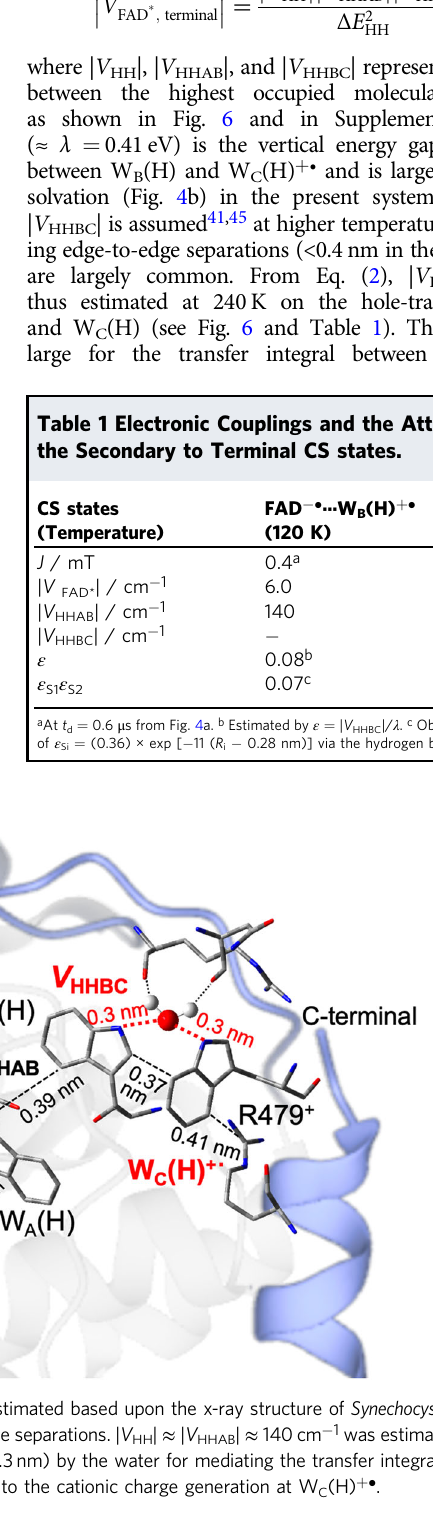
Supplemental Table 5. As a result, the electronic coupling (| V FAD * , = 1.5 cm − 1 to FAD * ) in the terminal CS state is attenuated terminal |